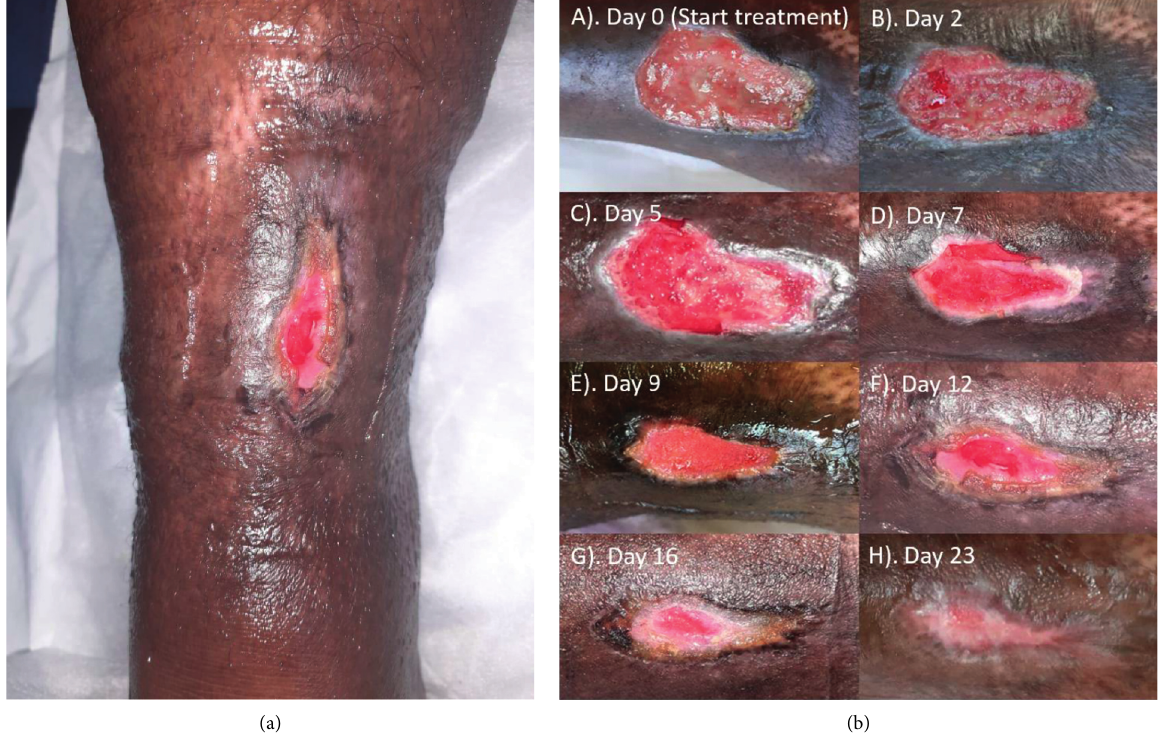
Figure 2: (a) Photo of the wound illustrating the location on the leg. (b) Evaluation of L-Mesitran Foam dressing for the treatment of a chronic diabetic venous leg ulcer. After each dressing change, a picture was taken to monitor the wound progression.